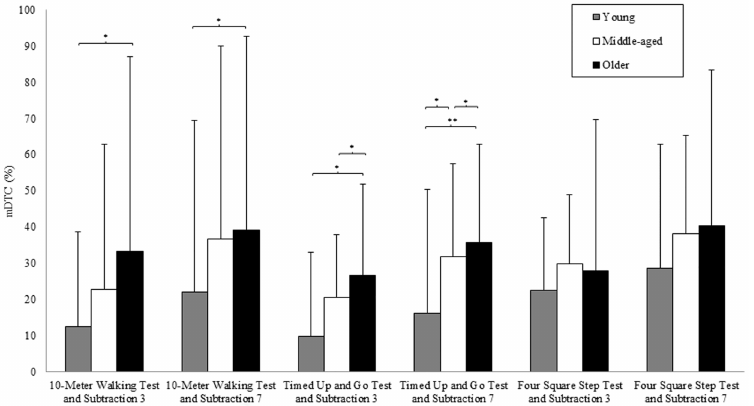
Fig 1. Combined mDTC. Mean dual-task costs (mDTCs) for the combinedmobility and cognitivetasks. Each bar representsthe averagescore for young (gray), middle-aged (white) and older subjects (black) in the different mobility tasks. The columns represent the means, and the error brackets represent the pertinent standarderror. * indicates p < 0.05; ** indicates p < 0.01.